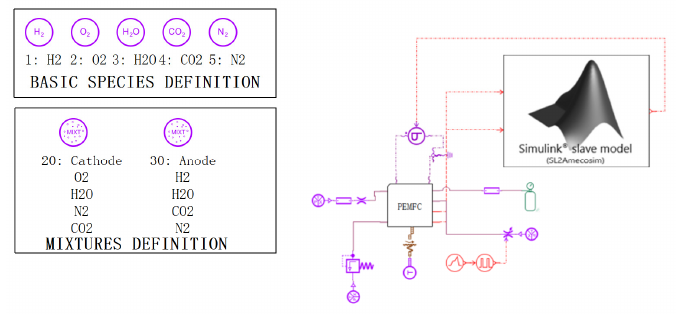
Figure 7. Cold-start model based on MPC control strategy.